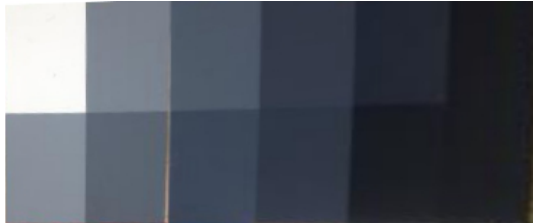
Figure 4. Segment no 2: 12- level greyscale (image obtained